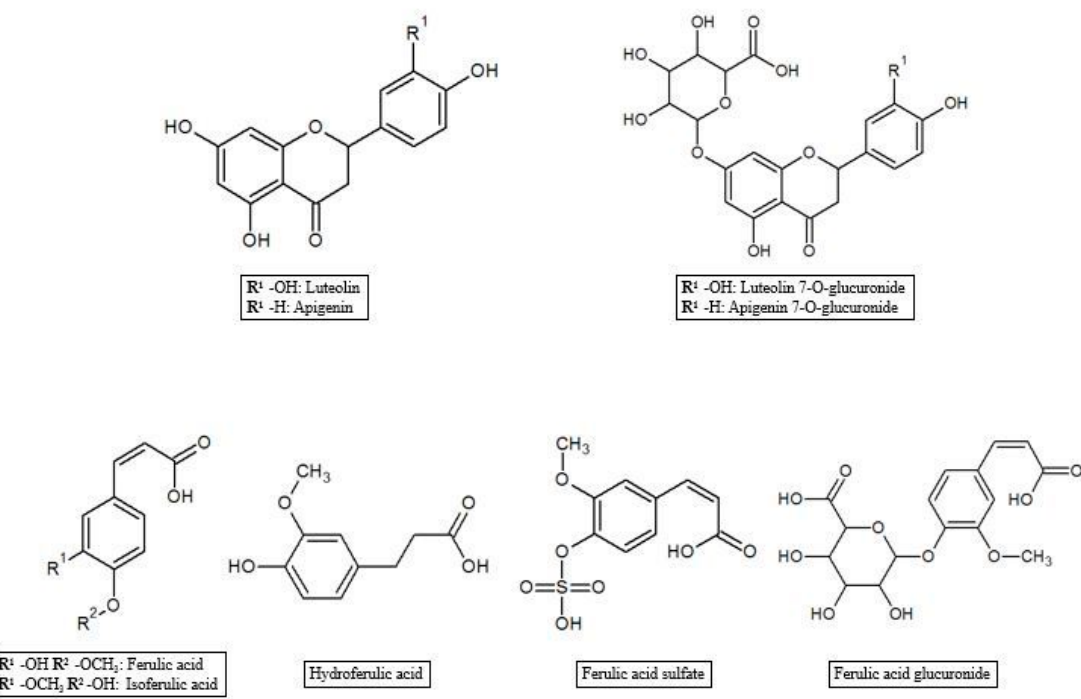
Figure 2. Luteolin, apigenin and ferulic acid metabolites.